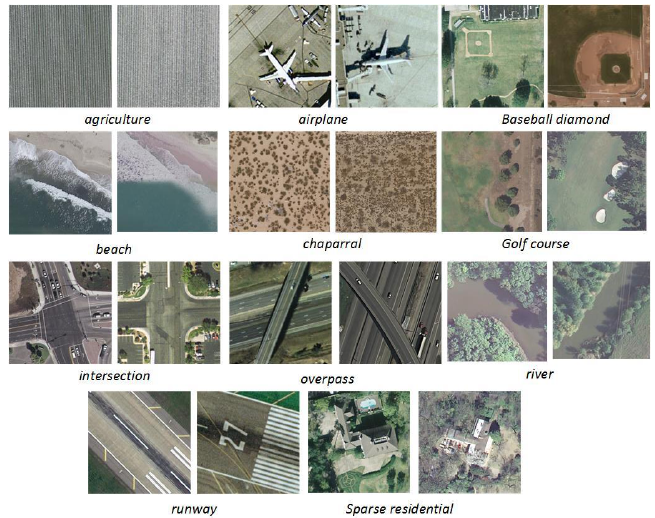
Figure 10. Two Example images of categories misclassified with KCRC method but classified accurately with two-step classification method in UC_MERCED dataset.